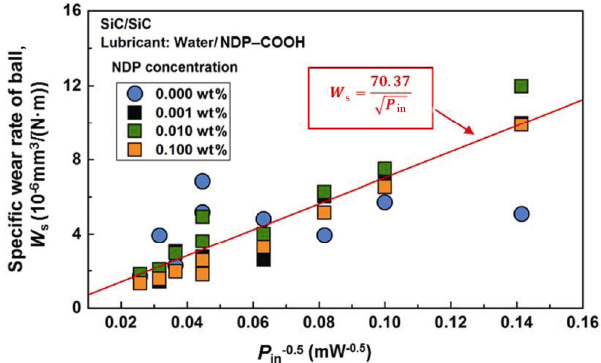
Fig. 16 Relationship between the specific wear rate of ball and  0.5 P . Red curve fitted from NDP–COOH data in 0.001 in wt%, 0.01 wt%, and 0.1 wt% with R 2 =